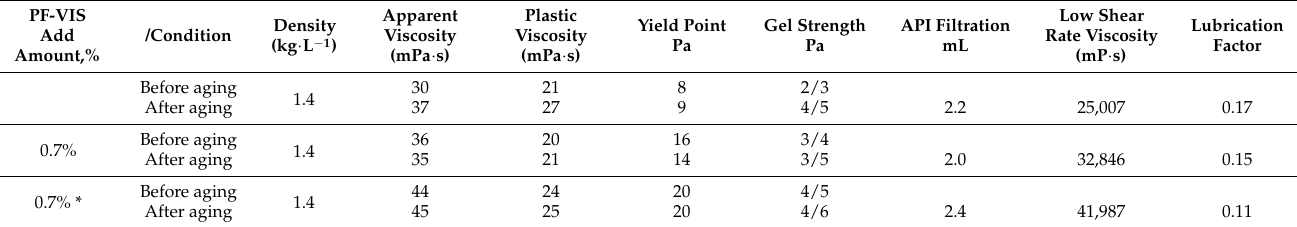
Table 1. The effect of viscosity increasing material to solid-free organic salt drilling fluid.